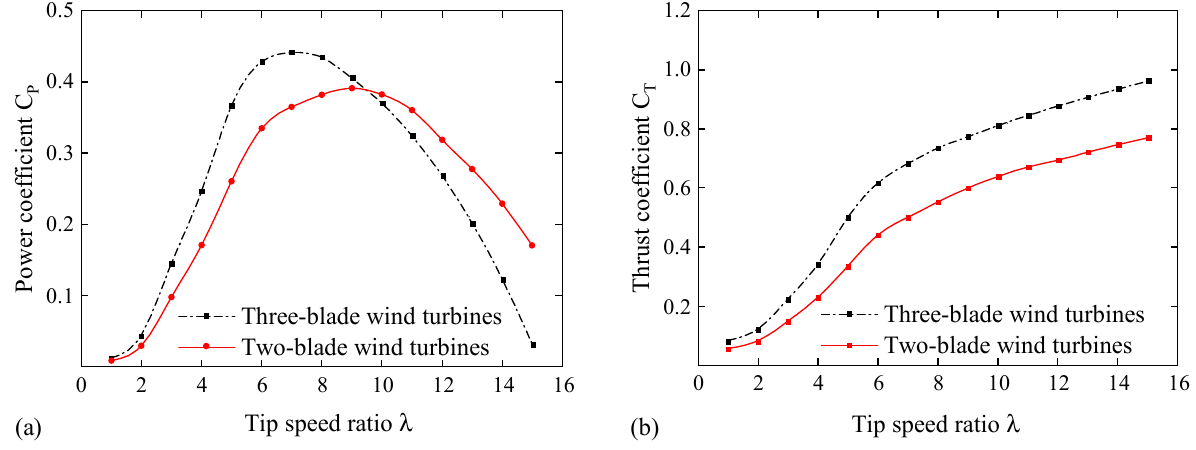
Figure 3. Power coefficient and thrust coefficient. ( a ) Power coefficient; ( b ) Thrust coefficient.